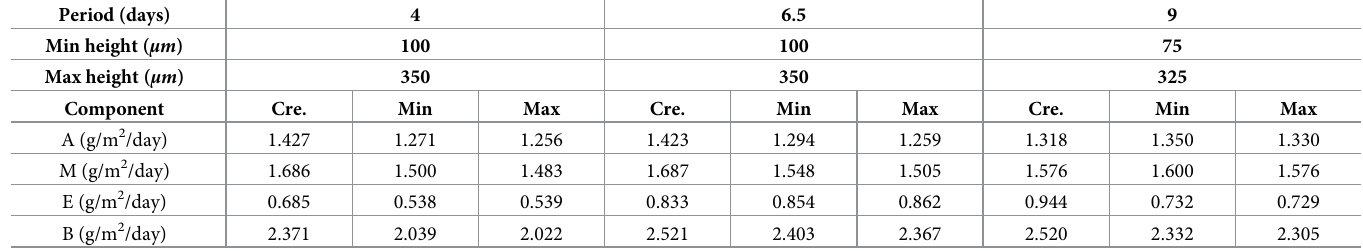
Table 2. Productivity comparison for harvest using crenellated scraping shape of size 250 μm , compared with uniform harvest at the lower/upper height of the cre- nels (with identical harvest period). Period (days) 4 6.5 Min height ( μm )